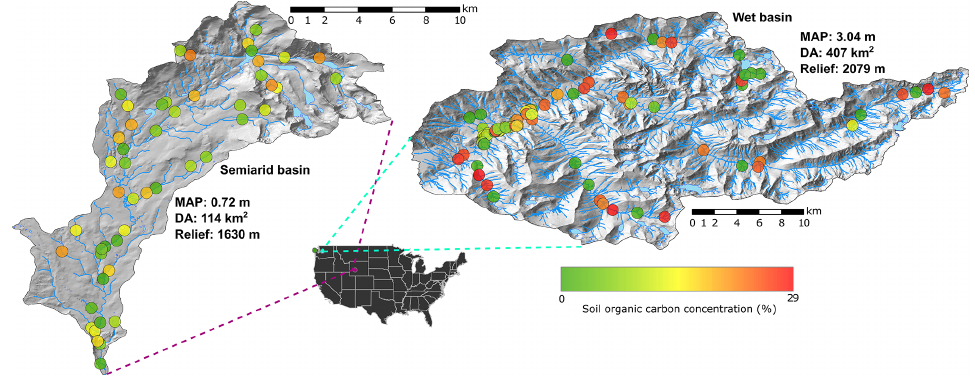
Figure 1. Hillshade showing the location, sampling sites, and stream network of the sampled basins. Big Sandy, Wyoming (42.69 ◦ , − 109 . 25 ◦ ), is on the left and MF Snoqualmie, Washington (47.53 ◦ , − 121 . 52 ◦ ), is on the right. Circles represent sampling locations at which floodplain soil OC was measured. Sample sites are colored by OC concentration. Mean annual precipitation (MAP), drainage area (DA), and relief are given for each